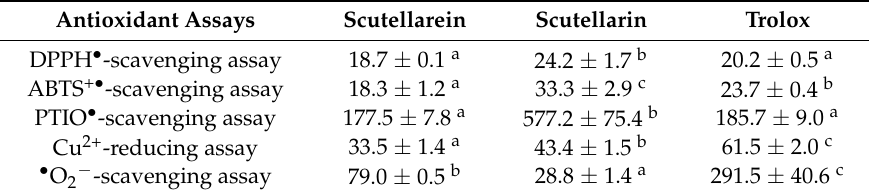
Table 1. IC 50 values ( µ M) of scutellarein and scutellarin in five antioxidant spectrophotometric assays. Antioxidant